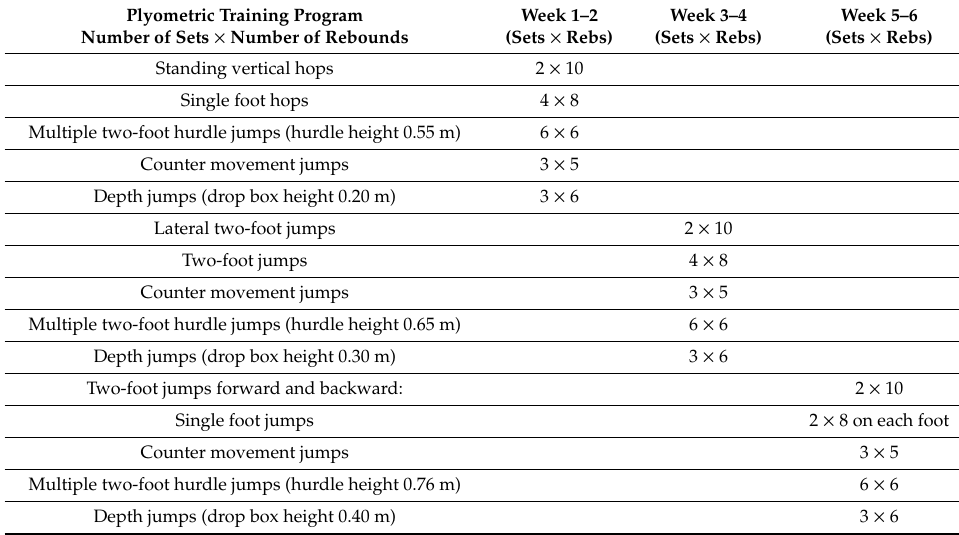
Table 1. Plyometric training program